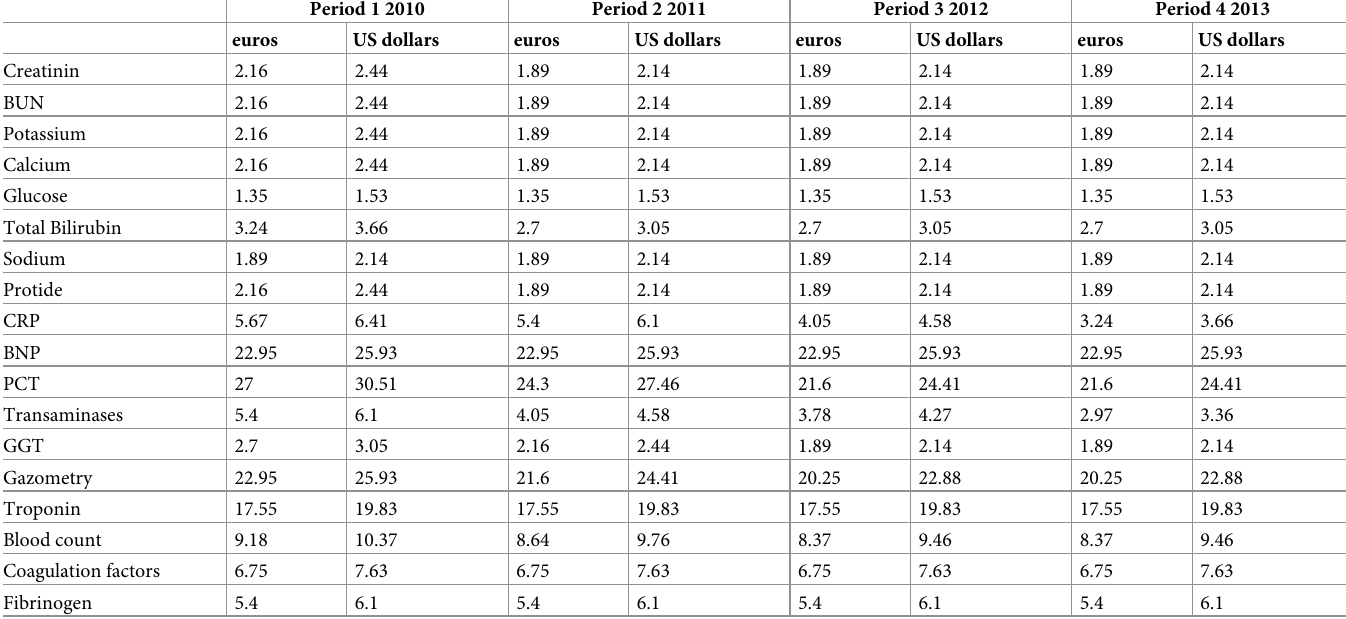
Table 2. Cost £ of biological tests.